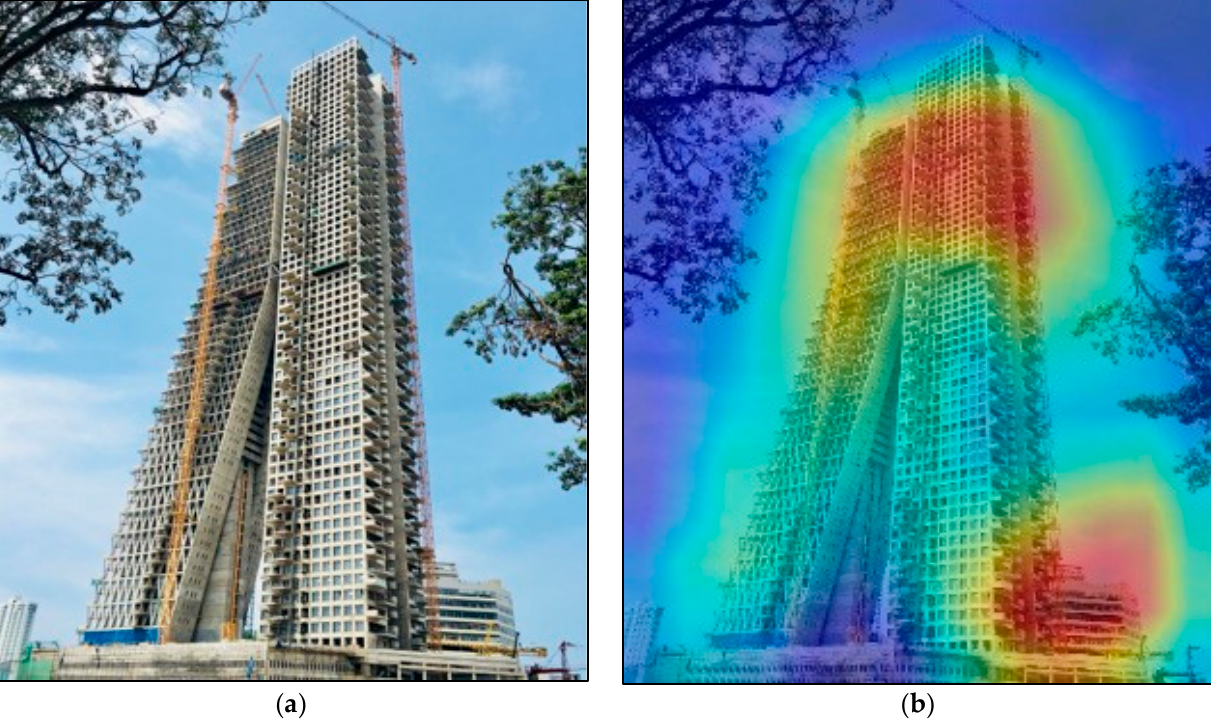
Figure 3. Exemplified image processing. ( a ) Input image: inserted Image; ( b ) output image: heat map of the features used to make the correct predictions.